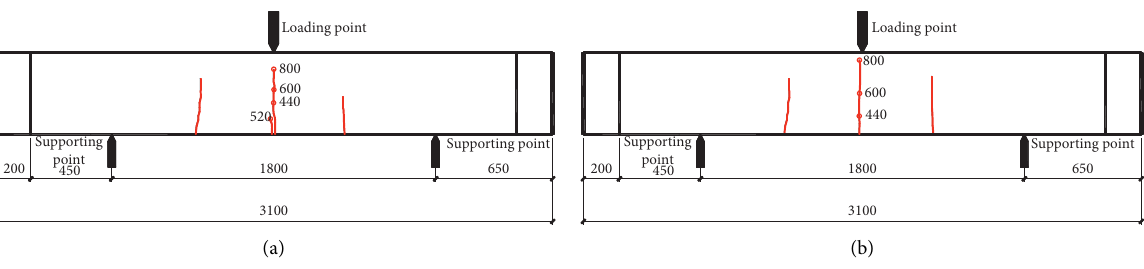
Figure 14: Crack distribution of SC-P2. (a) Crack distribution on Side A and (b) crack distribution on Side B.